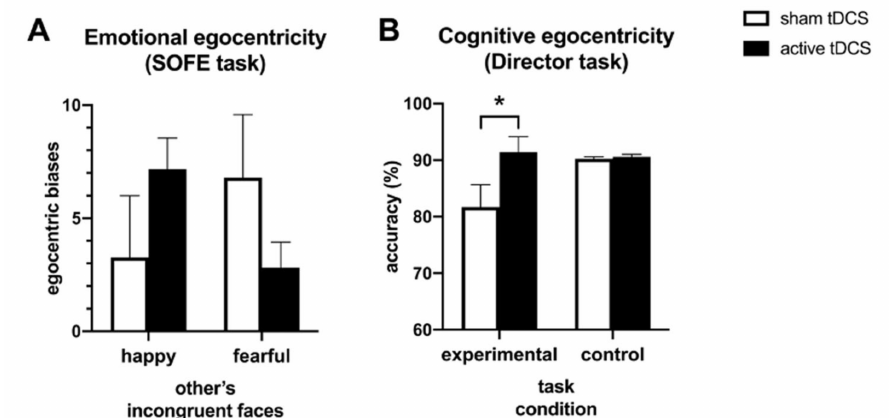
Figure 2. Effects of anodal sham and active tDCS to the rSMG on egocentric biases (mean + SE) assessed in the SOFE and Director task. ( A ) Emotional egocentric biases of the SOFE task were calculated by comparing emotional ratings of others’ facial expressions with a situational, emotion- inducing context to emotional ratings of identical facial expressions without a situational context, with higher scores indicating stronger egocentricity. Biases after active and sham tDCS were plotted for judging other’s happy versus fearful facial expressions. ( B ) Egocentric biases in the Director task were based on the accuracy of switching between two different viewpoints, with higher accuracy indicating lower egocentricity. Biases after active and sham tDCS were plotted for the experimental and control task conditions. * p <